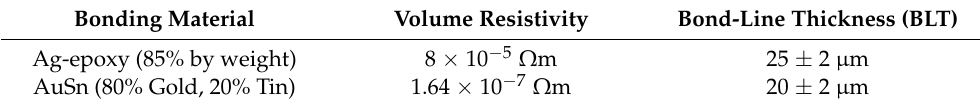
Table 1. Commercially Die-substrate Bonding Material